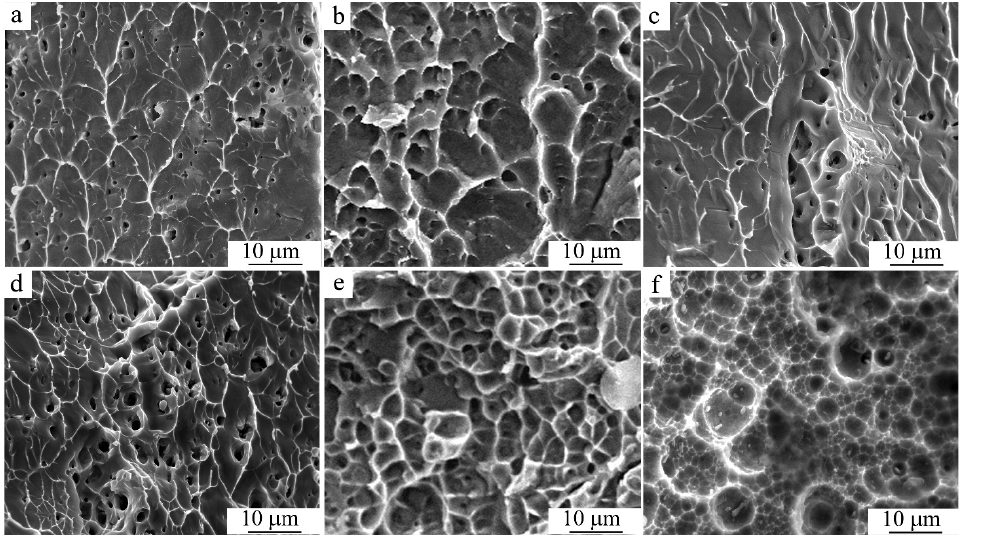
Figure 28. Fractography of the ( a , d ) Ti 49.5 Ni 50.5 alloy after ( a ) MPR by 30% and ( d ) MPR by 30% and PDHT at 773 K for 1 h; ( b , e ) Ti 49 Ni 51 alloy after ( b ) quenching at 1173 K for 1 h, and ( e ) MPR by 30% and PDHT at 773 K for 1 h; ( c , f ) Ti 49.4 Ni 50.6 alloy after ( c ) ECAP 8 passes + 723 K for 1 h, and ( f ) HPT 5 rev + 823 K for 1 h.